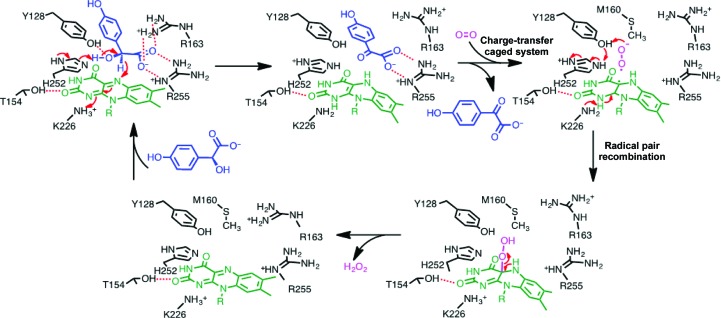
The catalytic cycle of Hmo in the conversion of (S)-mandelate to benzoylformate with the concomitant formation of H2O2.